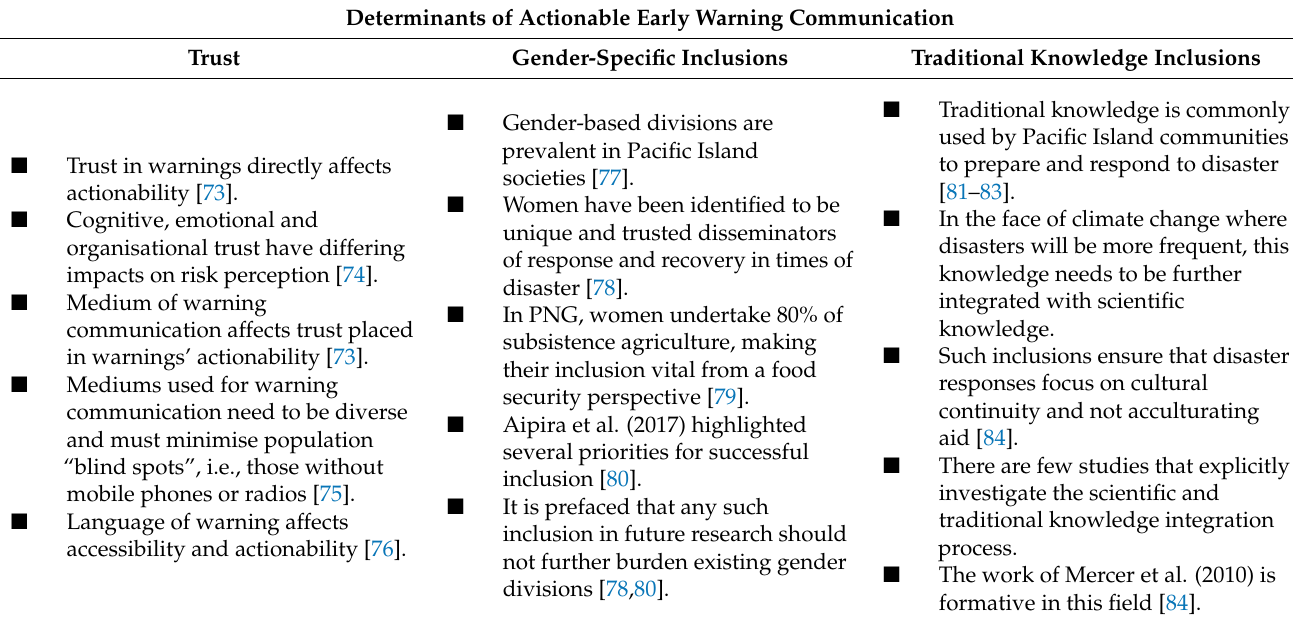
Table 3. Determinants of actionable early warning communication in Pacific Island Countries as identified by a literature review. Determinants of Actionable Early Warning